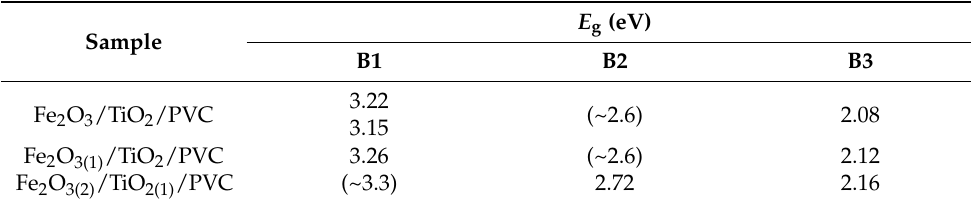
Table 2. Energy positions of additional levels in Fe 2 O 3 /TiO 2 /PVC samples within the forbidden zone of